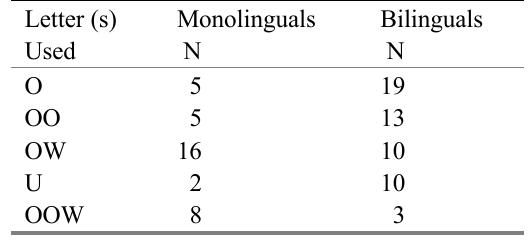
Table 12. Misspellings for the phoneme /u:/ in shoe Letter